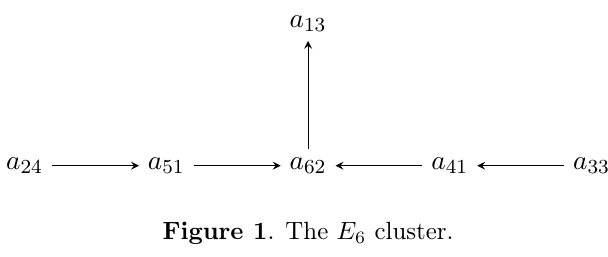
Figure 1 . The E 6